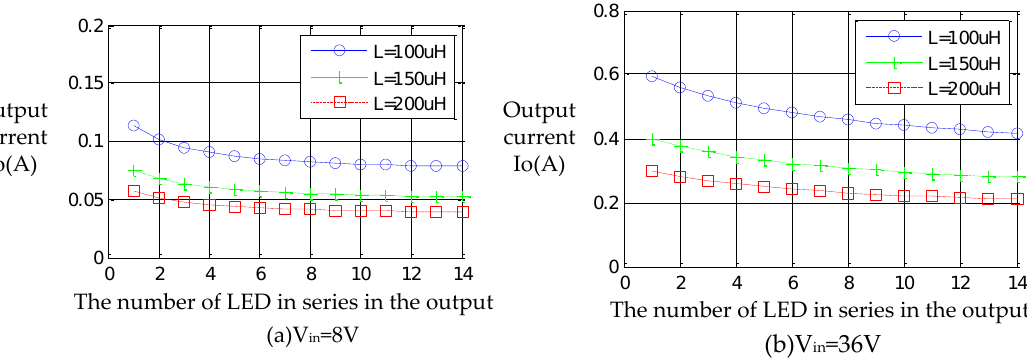
Figure 7. Output boundary current in different input voltages with different self-inductance.